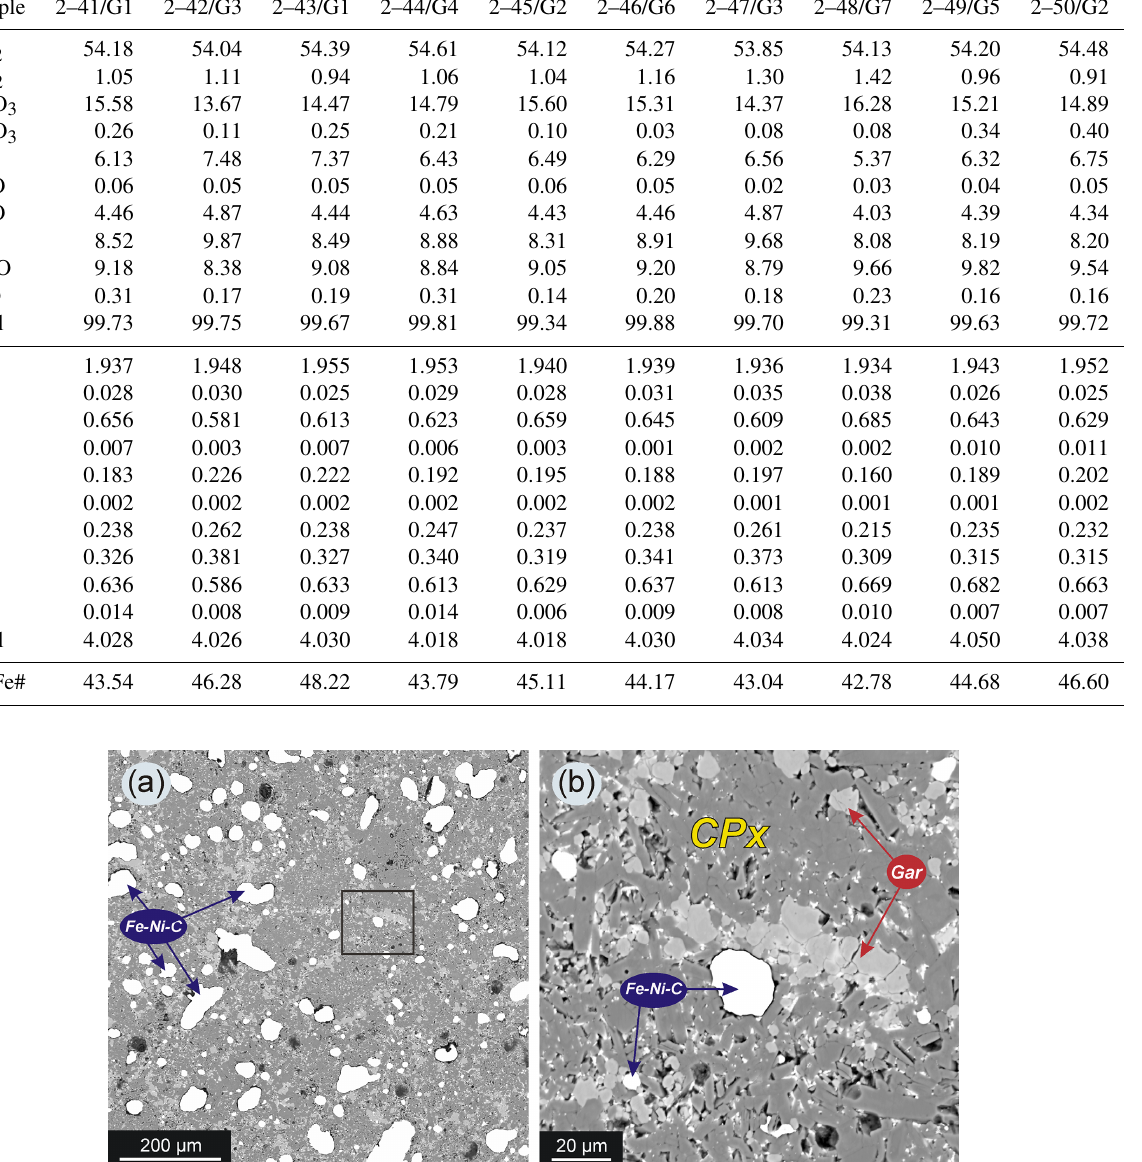
Table 3. Representative chemical analyses of clinopyroxene from the experiments. Sample